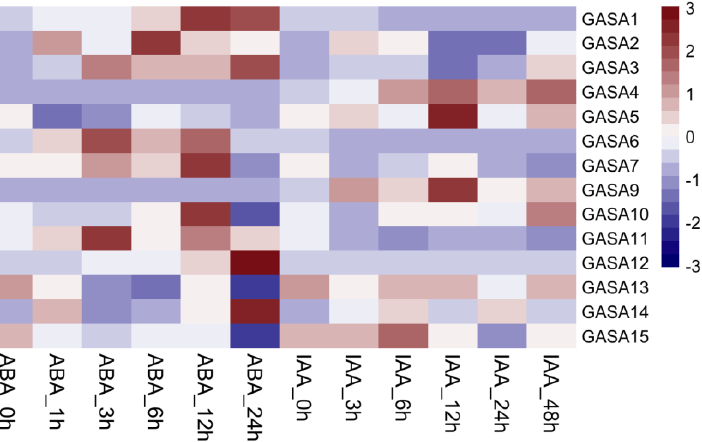
Figure 8. Expression analysis of PmGASAs in response to ABA and IAA treatments. The heatmap displayed the average relative expression levels of PmGASAs from the qRT-PCR assays.